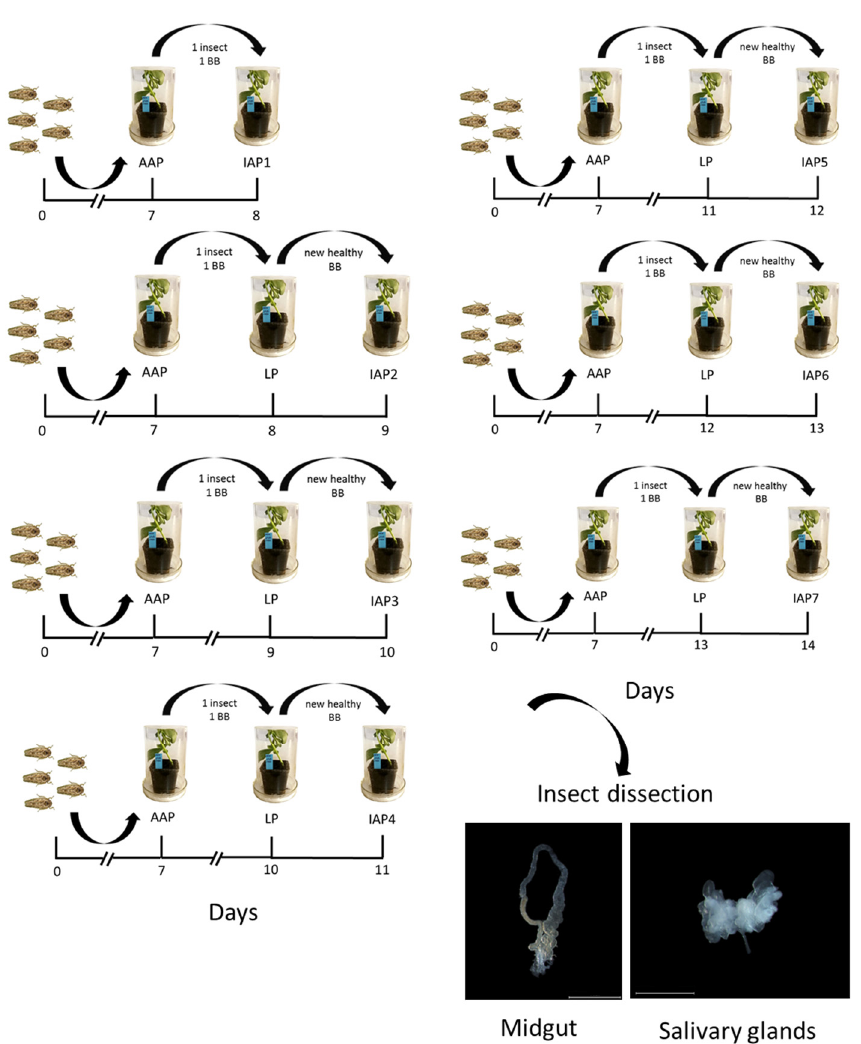
Figure 1. Experimental procedure followed for flavescence dorée phytoplasma (FDP) transmission trials. Adult E. variegatus specimens were exposed to an FDP-infected broad bean (BB) for